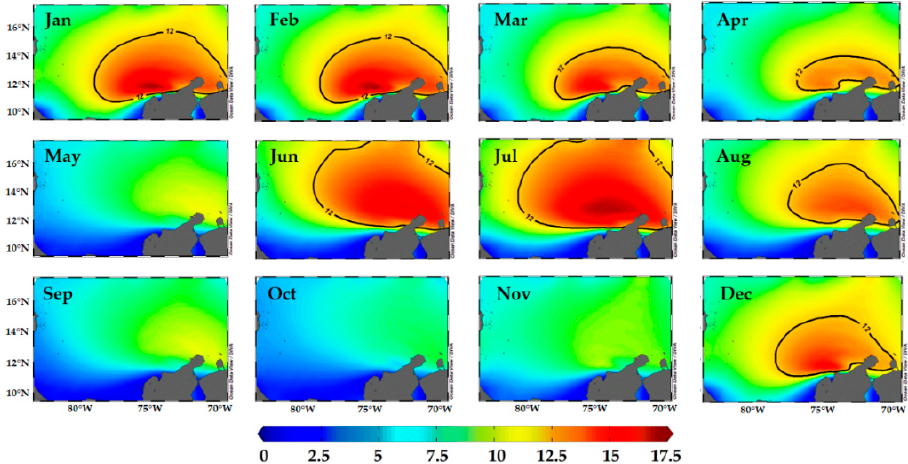
Figure 3. Monthly average of wind speed (m/s) of CLLJ in the Caribbean at 925 hPa. The black contour line delimits the presence of the CLLJ in the study area.